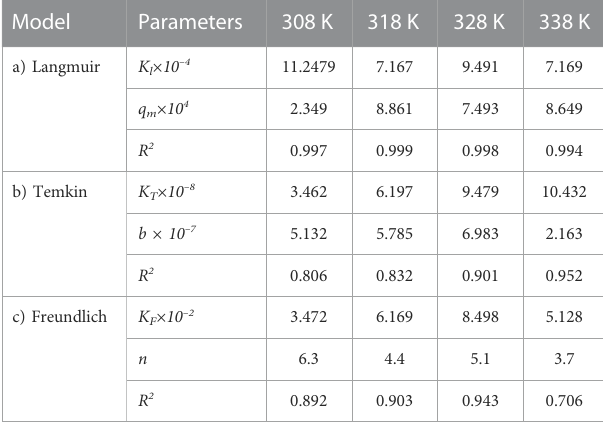
TABLE 4 Parameters of a) Langmuir, b) Temkin, and c) Freundlich isotherm models at different temperatures using Oil sludge 1 as carbon active at pH = 5 and adsorbent concentration of 100 mg/L.